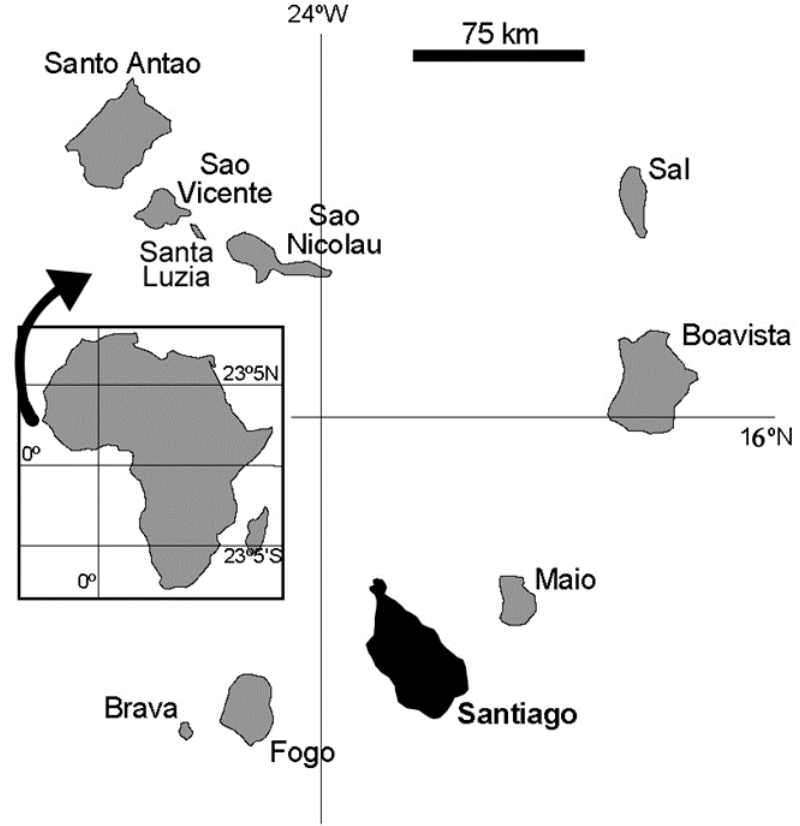
Figure 1. Cape Verde archipelago and its location.